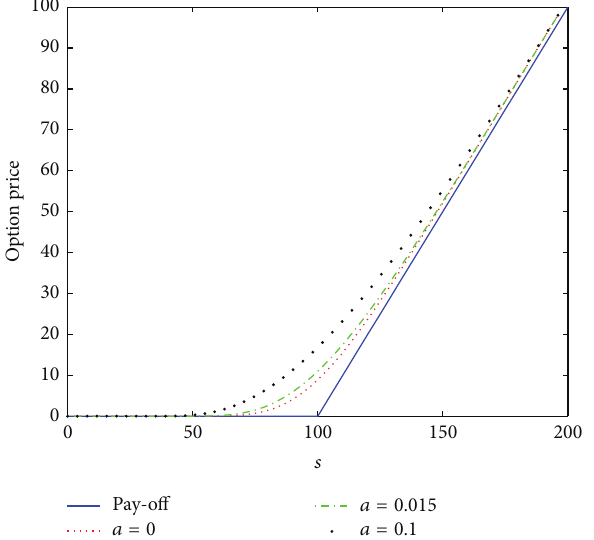
a = 0.015 a = 0.1 Figure3:OptionpricingofavanillaEuropeancalloptionforseveral values of parameter 𝑎 at maturity time 𝑇 = 1 year, where ℎ = 4 and Δ𝑡 = 0.02